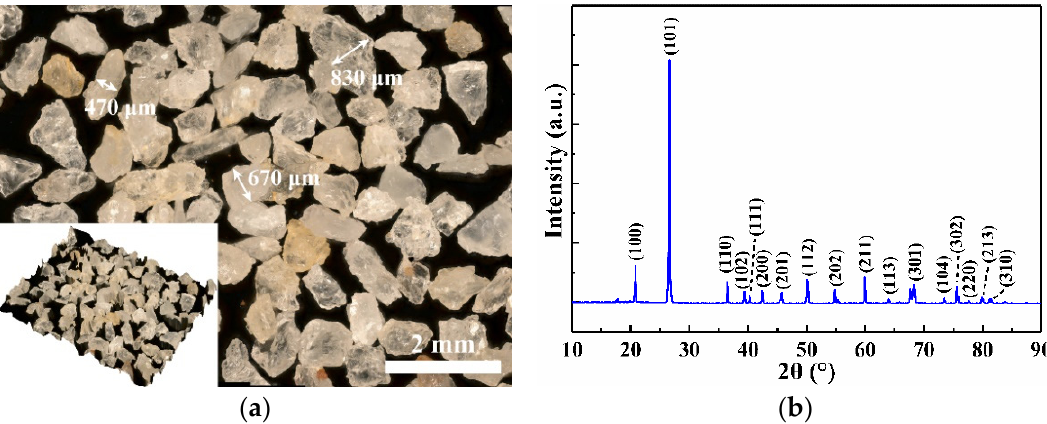
Figure 1. Characteristics of abrasive sand particle, ( a ) Surface morphology, ( b ) XRD pattern.